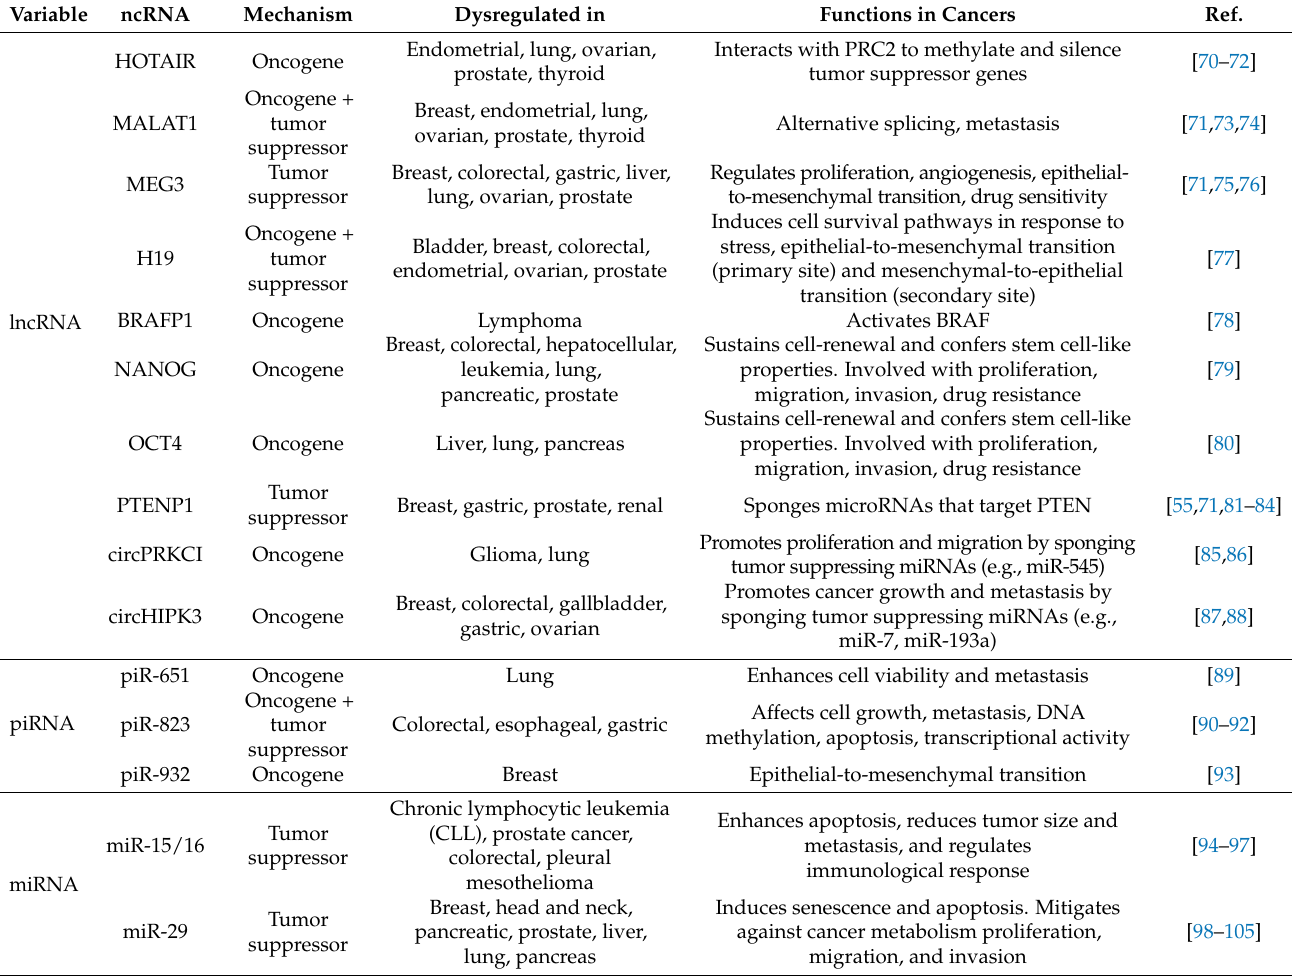
Table 1. Dysregulated ncRNAs in